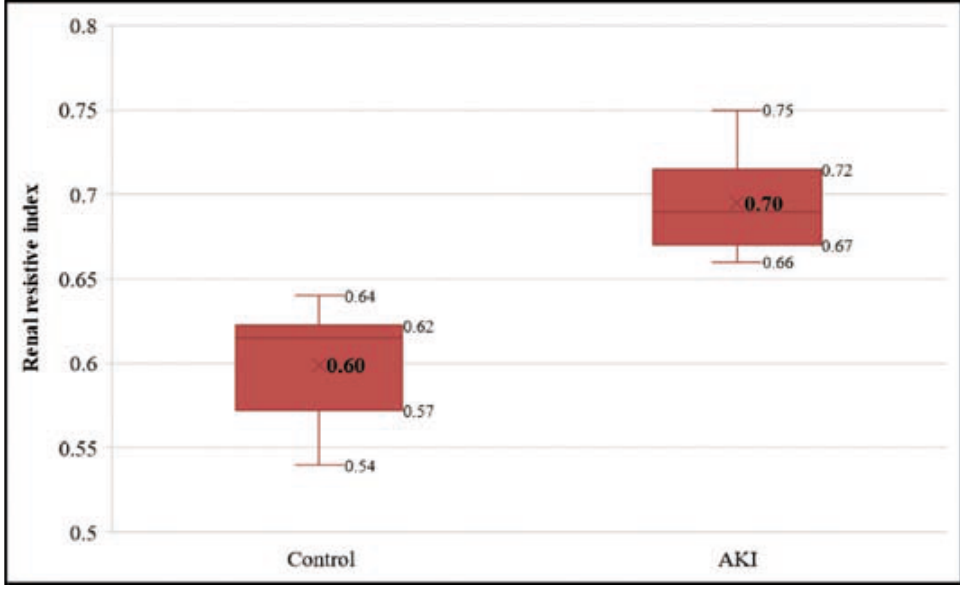
Fig. 5. Whisker-plot of the RRI distribution in healthy dogs and dogs with AKI table 2. Renal parameters of healthy dogs and dogs with AKI (Mean ± SE) Group I Group II Parameters p-value (Healthy dogs) n=10 (Dogs with AKI) n=27 Blood Urea Nitrogen (mg/dL) 19.00 ± 1.53 85.92 ± 7.79** <0.001 Serum Creatinine (mg/dL) 1.01 ± 0.09 UPC ratio Mean arterial pressure (mm of Hg)